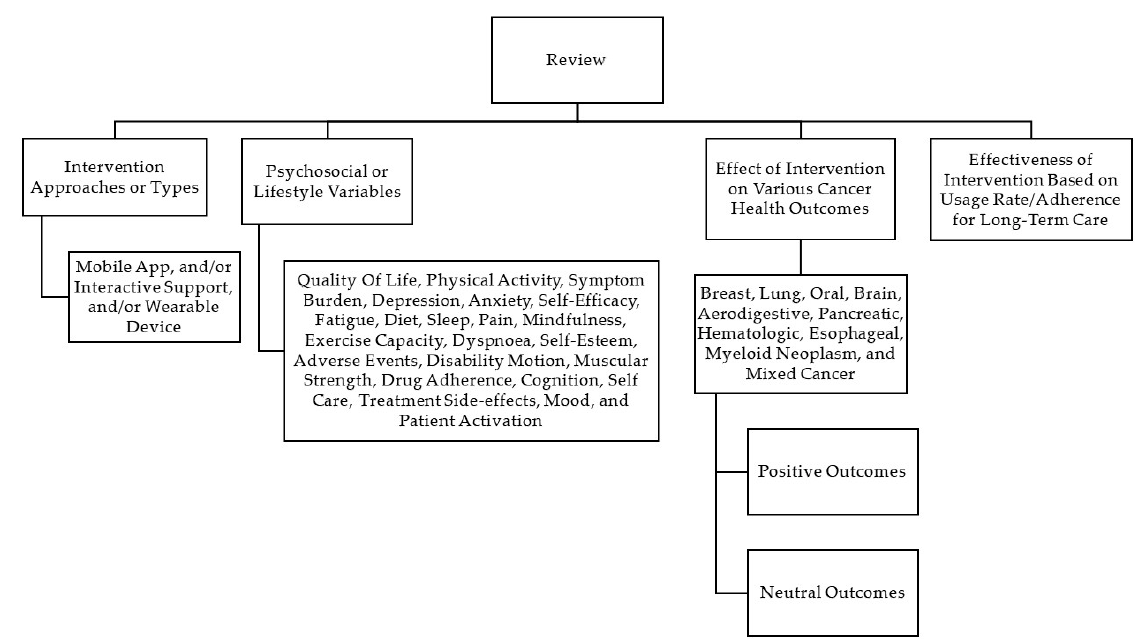
Figure 2. Categorization of studies included in the scoping review based on methods and outcomes.